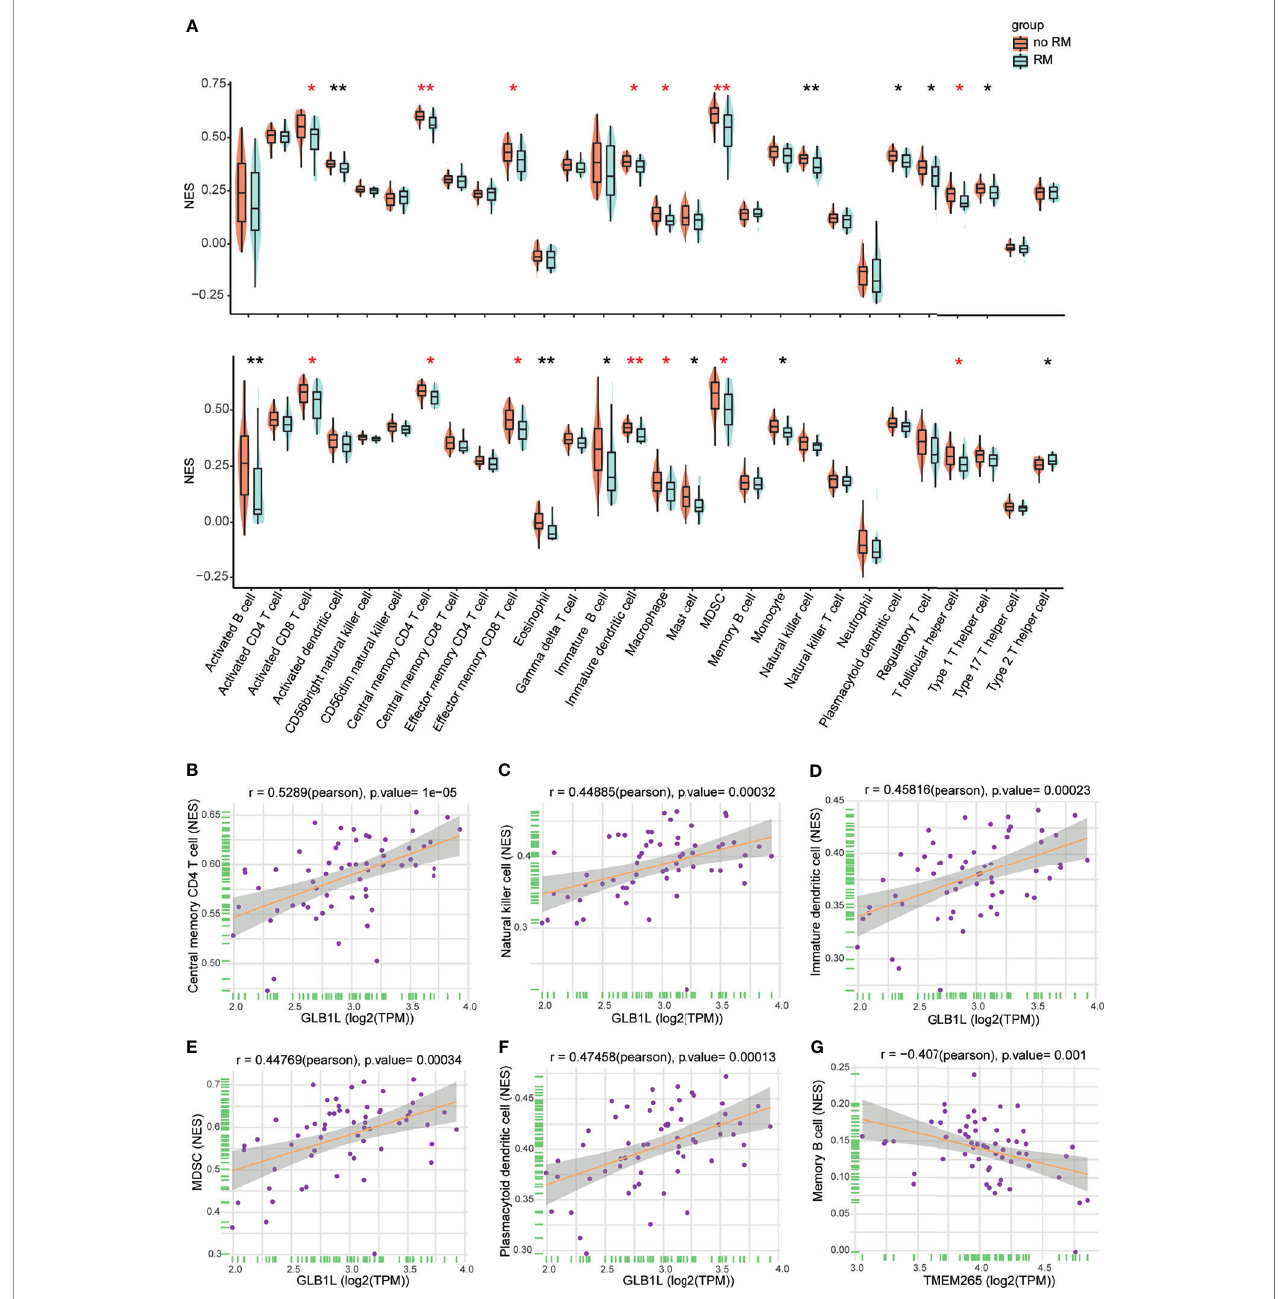
FIGURE 5 | Associations of in fi ltrating immune cells with prognosis and the signature in NPC. (A) NESs of in fi ltrating immune cells in the RM and no-RM groups (top). NESs of in fi ltrating immune cells in the RM and no-RM groups of the GEO cohort (bottom). Red indicates statistical differences in both datasets. *p < 0.05, **p < 0.01. (B – F) The expression level of GLB1L was positively correlated with in fi ltrating immune cells. (G) The expression level of TMEM265 was negatively correlated with in fi ltrating immune cells. A correlation coef fi cient > 0.4 was